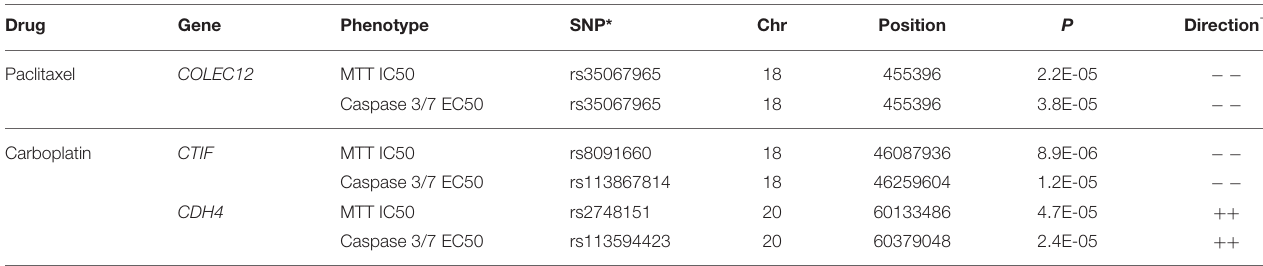
TABLE 2 | Gene regions with SNPs associated with both phenotypes for a given drug.